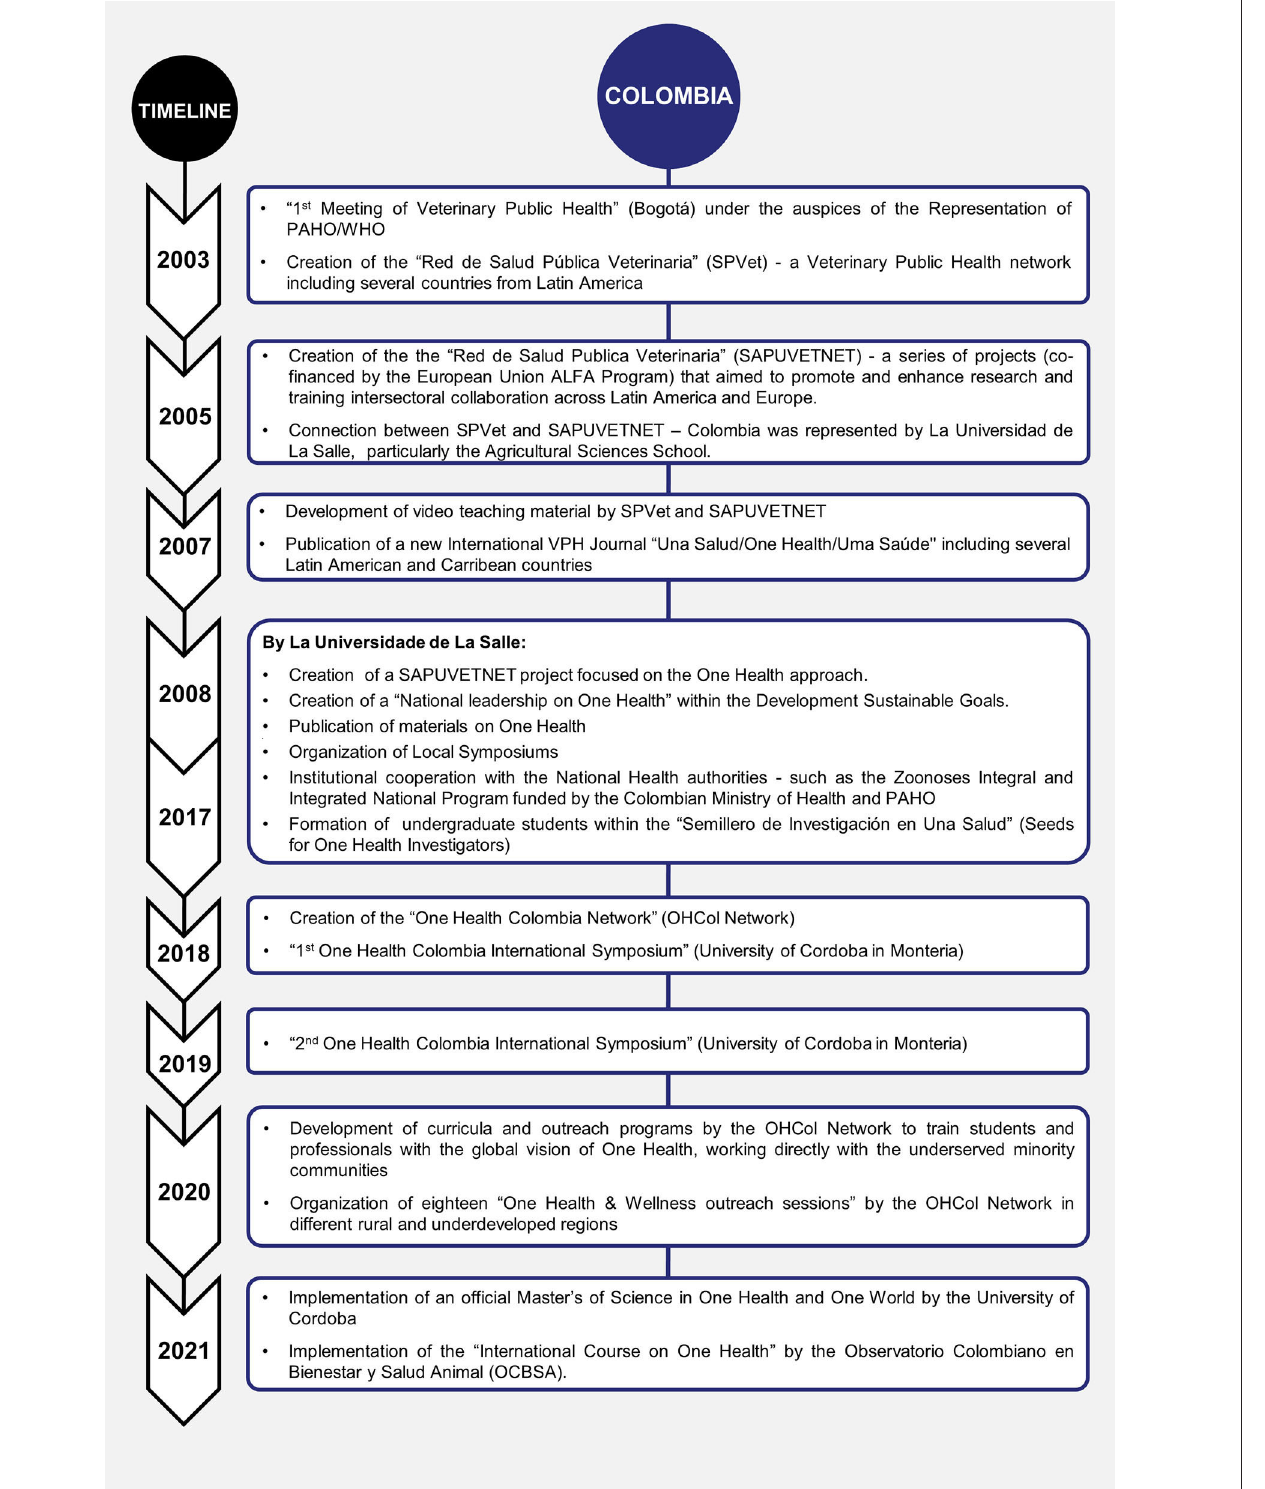
Frontiers in Public Health |